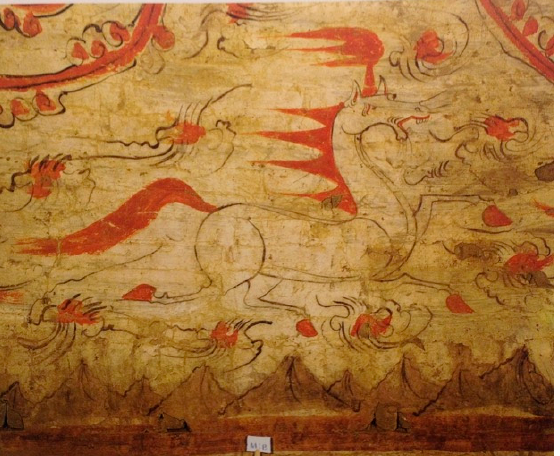
Figure 18. Heavenly horse, Dingjiazha M5 north ceiling slope of front chamber, wall painting, Later Liang to Northern Liang dynasty (386–441). (Jiuquanshi Bowuguan 1998, p. 105). ©Wenwu Press. This figure published with permission of Wenwu Press and cannot be used or copied without their